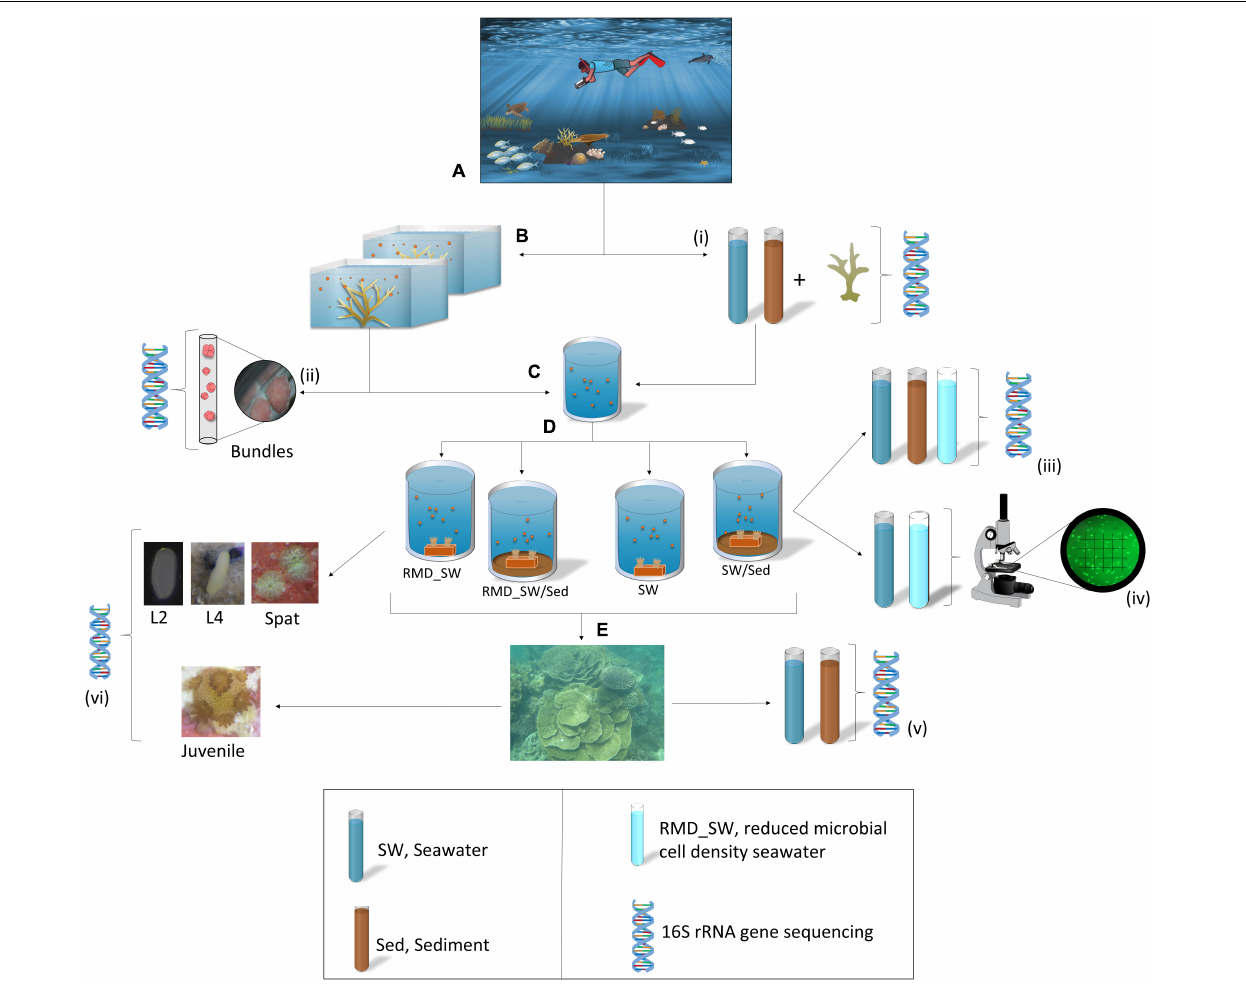
FIGURE 1 | Sampling and experimental design. (A) Acropora digitifera adult coral colonies were relocated from the reef to the Coral Bay jetty. (B) A few hours prior to spawning colonies were placed into individual tubs containing seawater. (C) Egg–sperm bundles were collected for fertilization, and (D) 8 h old larvae were transferred to four experimental treatments for larval rearing: RMD_SW, reduced microbial cell density seawater; RMD_SW/Sed, reduced microbial cell density seawater and sediment; SW, seawater, SW/Sed, seawater and sediment. Seawater (SW) and sediment (Sed) samples were collected from the collection site and used in tanks during the manipulative experiment. (E) Once settled onto terracotta tiles, newly settled spat were deployed back onto the reef for 6 months. (i–iii,v,vi) : DNA symbols indicates where various samples ( n = 5 in all cases) were taken for 16S rRNA gene sequencing. (iv) Samples of SW and RMD_SW ( n = 3) were preserved in 2% formalin at 4 ◦ C and bacterial density was determined via microscopy. Symbols are from the Integration and Application Network